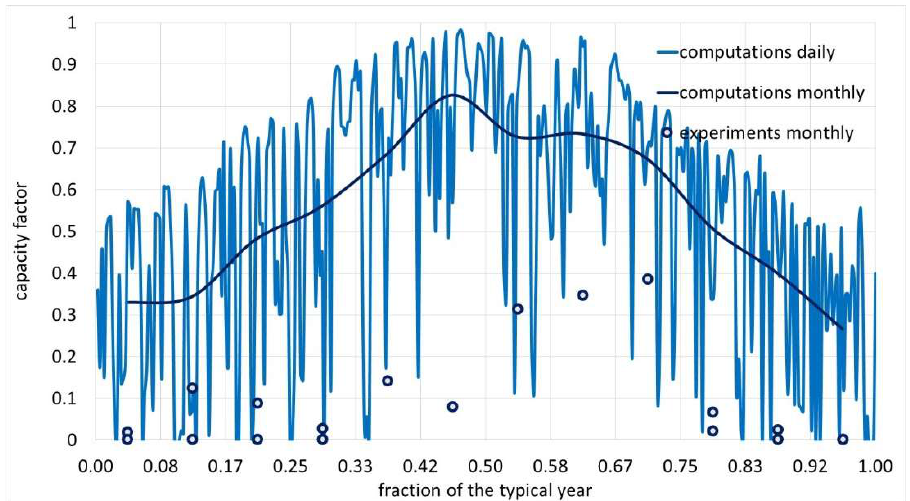
Figure 12. Crescent Dunes solar facility. Hourly, daily and monthly capacity factors from computations and monthly capacity factors from experiments. X is the fraction of the year. Y is the capacity factor. The experiments are the values measured since the completion of the plant (multiple entries per month).